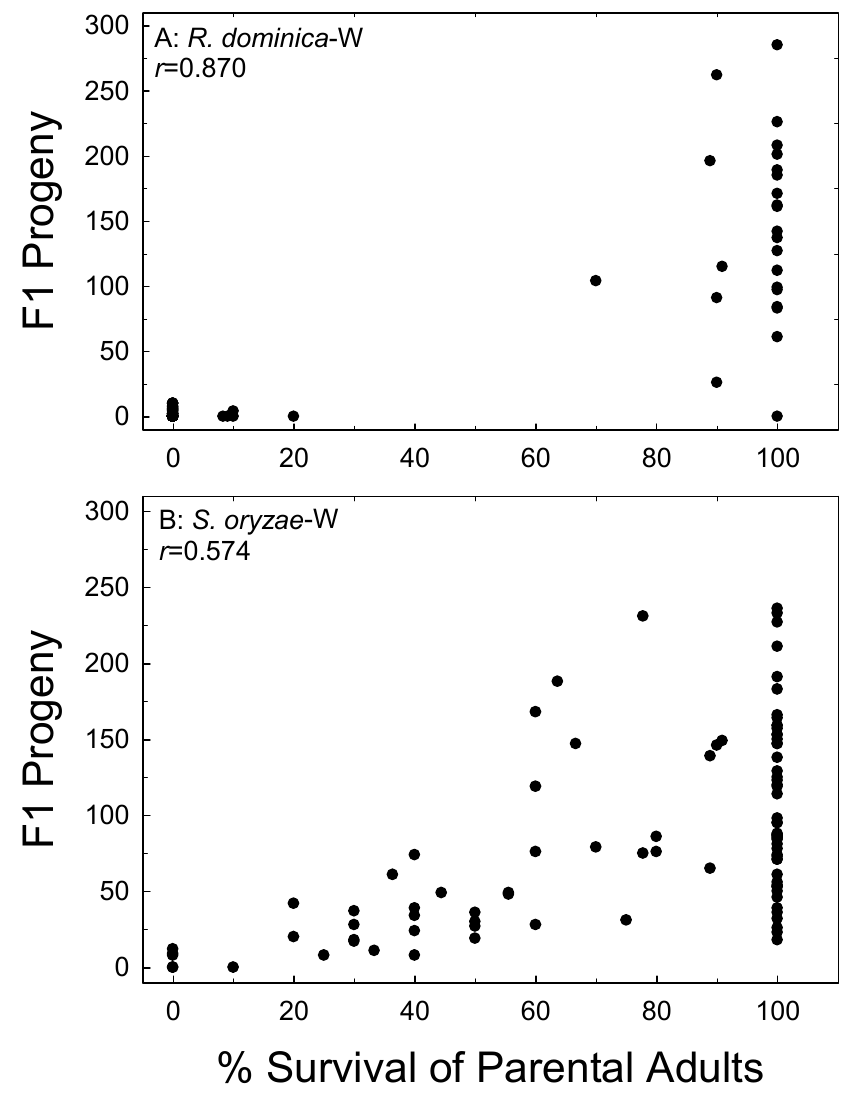
Figure 1. Correlation of parental survival with F 1 progeny production of R. dominica ( A ) and S. oryzae ( B ) on wheat (W). Data combined for all treatments and all bioassay months.